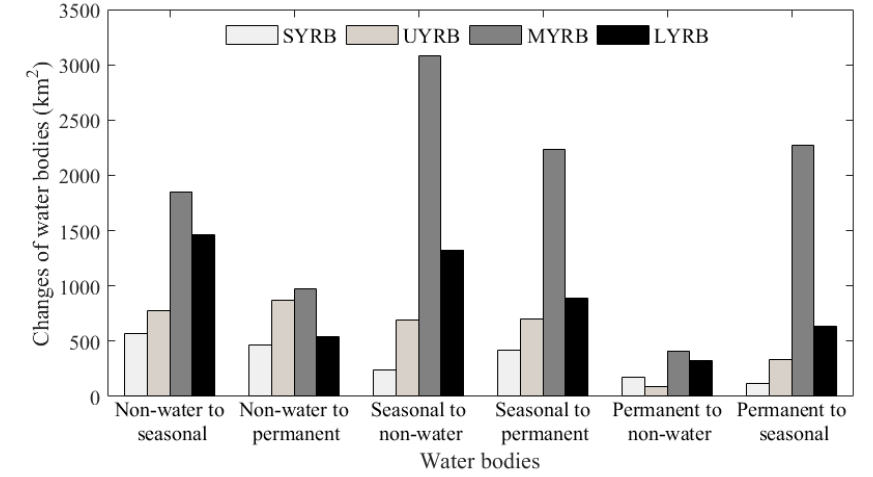
Figure 10. The conversion of surface water bodies from 1984 to 2018 for the sub-basins in the YRB.